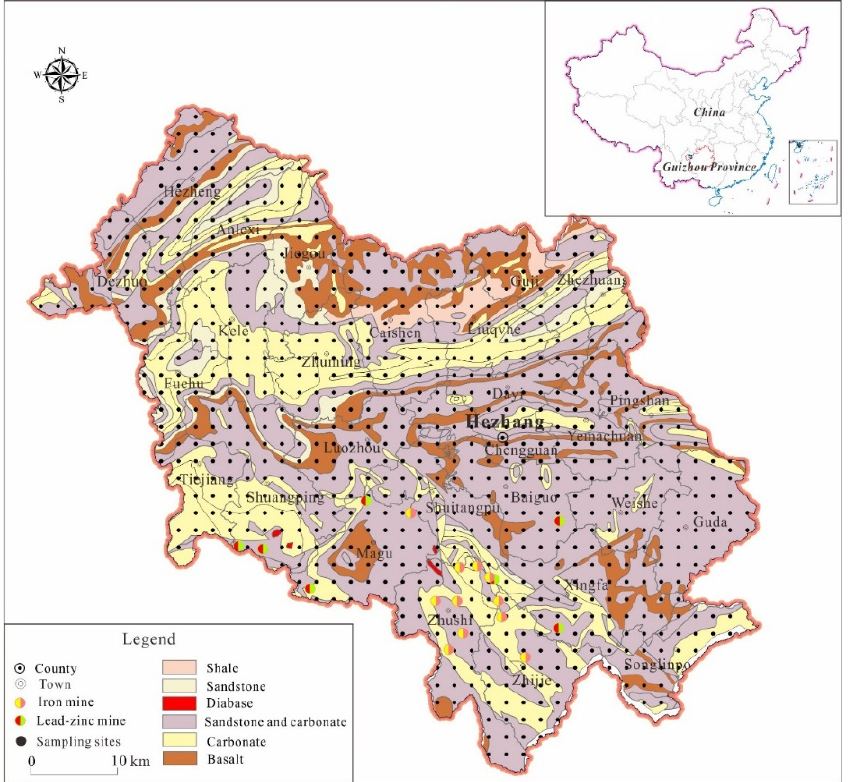
Figure 1. Map of the study area and location of sampling sites. The map of China was downloaded from http://bzdt.ch.mnr.gov.cn/ (accessed on 10 October